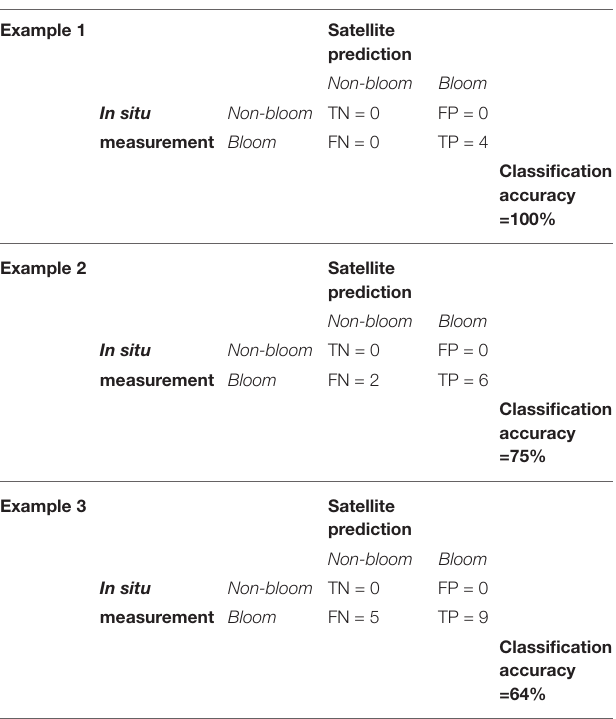
TABLE 1 | Confusion matrices describing the performance of the satellite classification model in terms of correctly identifying satellite-derived pixels as either “bloom” or “non-bloom.”